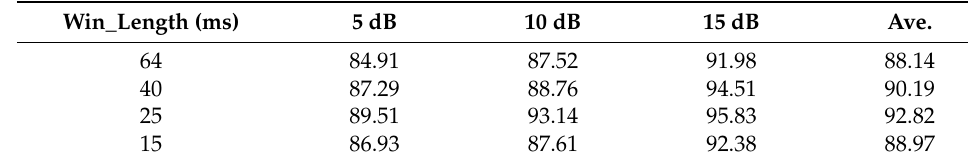
Figure 6. The result of the signal-to-noise ratio.